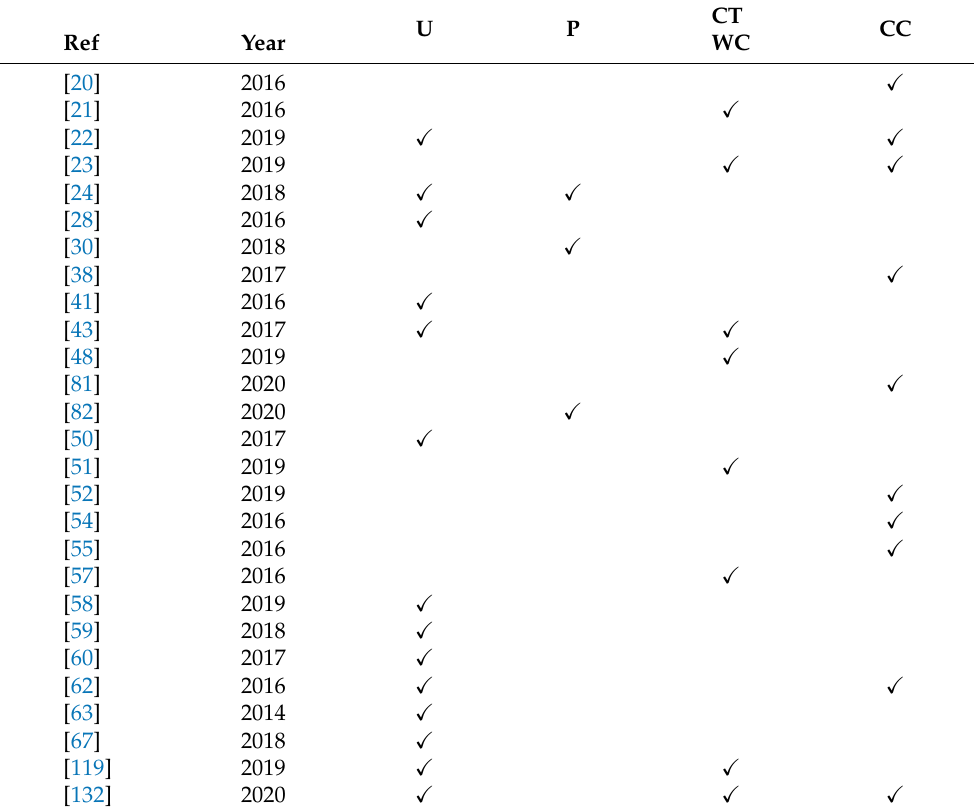
Table 5. Planning: final user oriented.